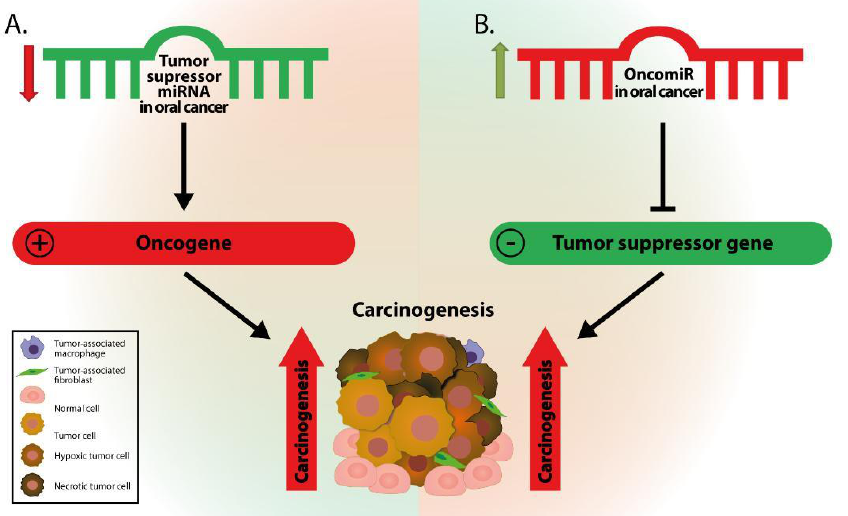
Figure 1. The impact of miRNA dysregulation on gene expression and, further, on carcinogenesis. ( A ) Downregulation of tumor suppressor miRNAs results in increased expression of oncogenes, and further to elevated levels of tumor-promoting proteins, leading to increased carcinogenesis. ( B ) Upregulation of an oncogenic miRNA (OncomiR) leads to repression of tumor suppressor gene expression and reduced expression of tumor suppressor proteins that further promote carcinogenesis.